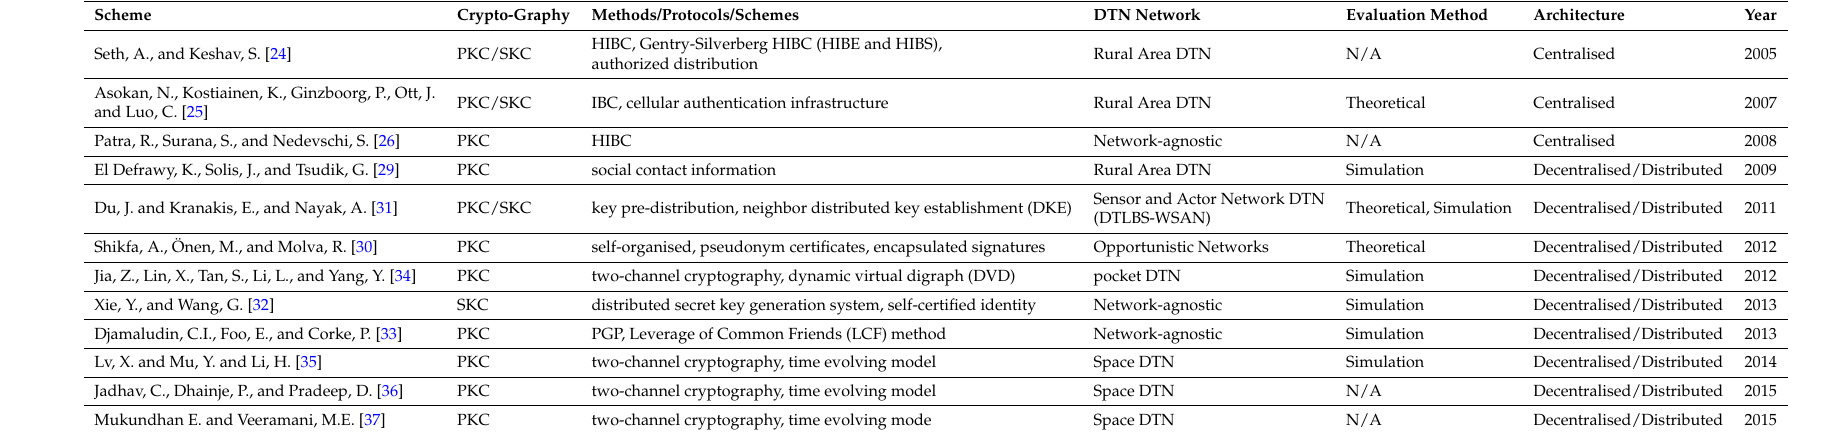
Table 1. Comparison of Security Initialisation Methods.